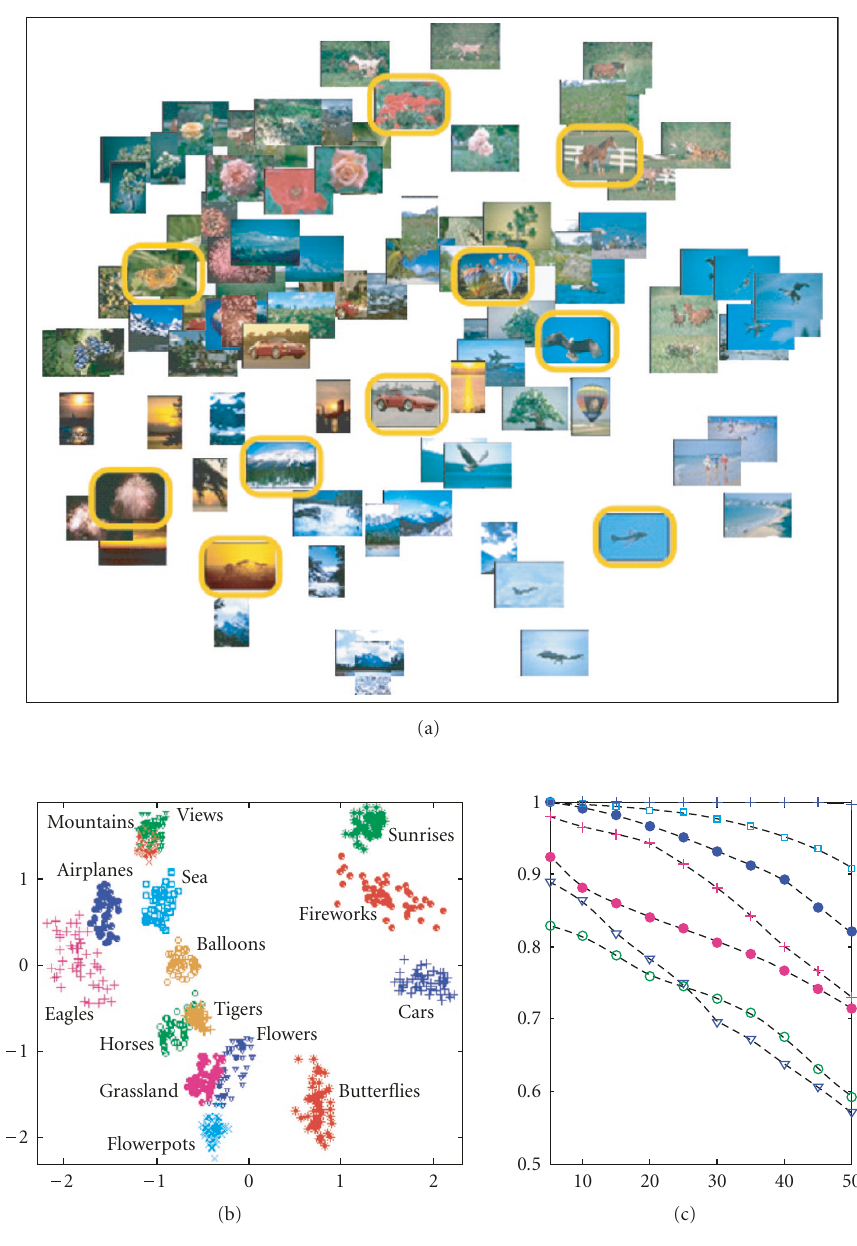
Figure 11: (a) The preliminary biplot (based on machine perception) used for prototyping. Based on the 10 highlighted representative images, a cognitive-biplot approximating user’s perceptual space was estimated; (b) the perceptual organization of the whole image